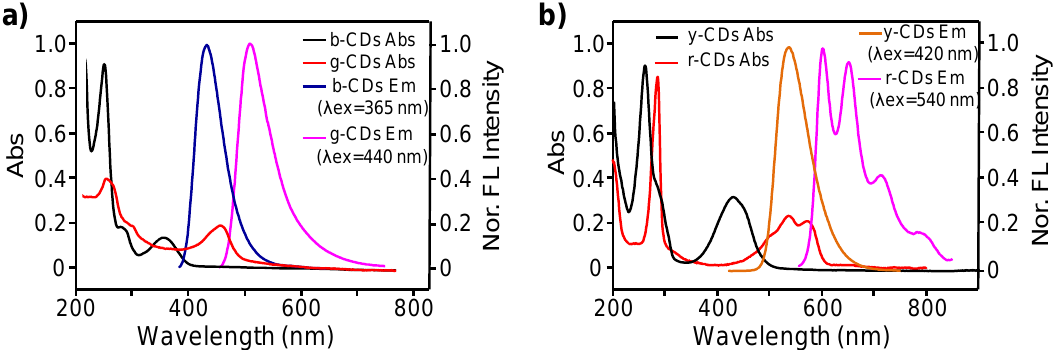
Figure 2. ( a ) Comparison of the UV-Vis absorption and PL emission spectra of b-CDs and g-CDs; ( b ) Comparison of the UV-Vis absorption and PL emission spectra of y-CDs and r-CDs.